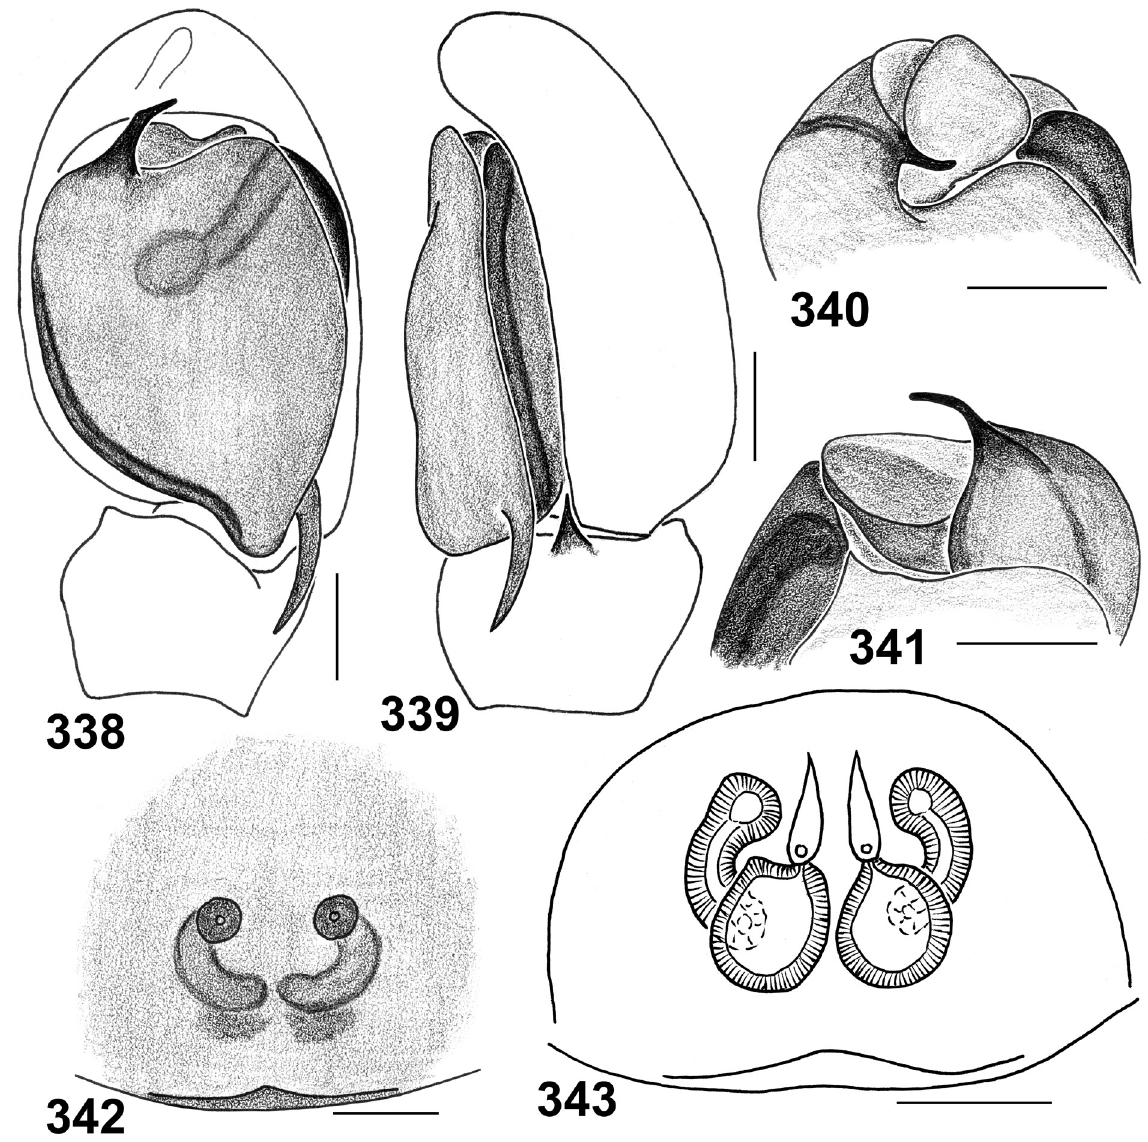
Figs 338–343. Stenaelurillus mirabilis Wesołowska & Russell-Smith, 2000, from Tanzania (Mkomazi GR, Ibaya camp). 338 . Male palp, ventral view. 339 . Male palp, retrolateral view. 340 . Embolic division, apical view. 341 . Embolic division, dorsal view. 342 . Epigyne, ventral view. 343 . Spermathecae, dorsal view. Scale bars: 0.1